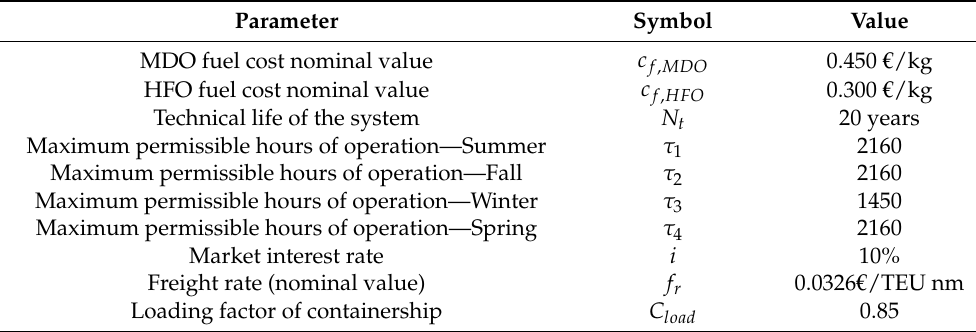
Table 23. Economic